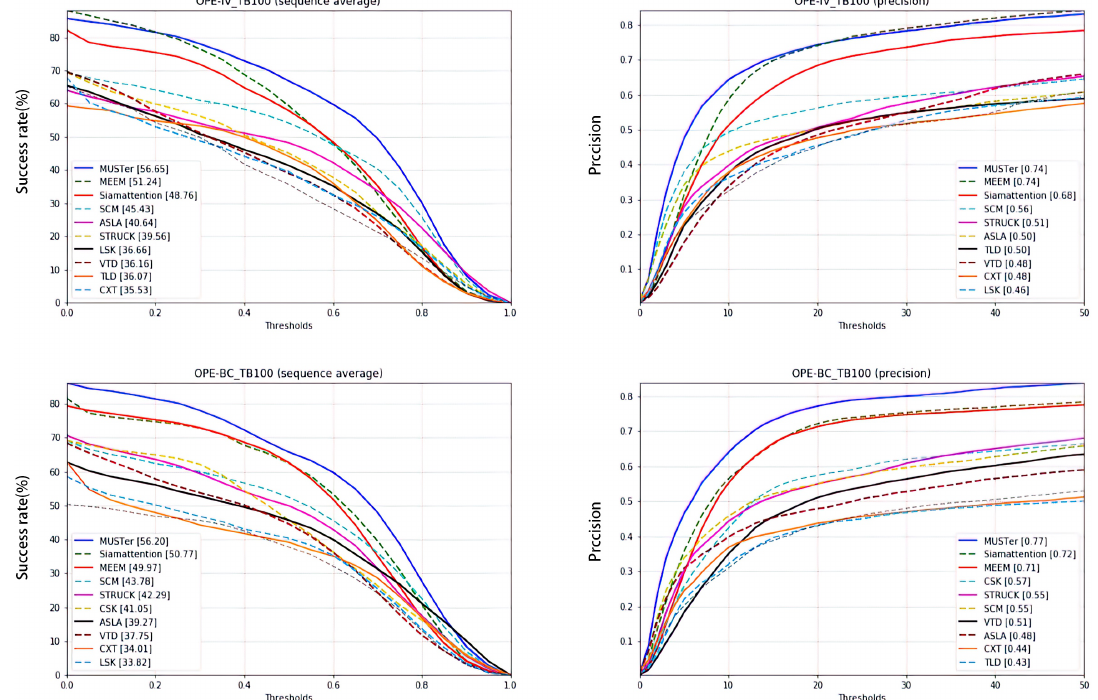
Figure 14. Success plot and precision plot of IV and BC. Under IV conditions, the proposed tracker is shown as the red real line, ranking third. Under BC conditions, it is shown as the green dotted line, ranking